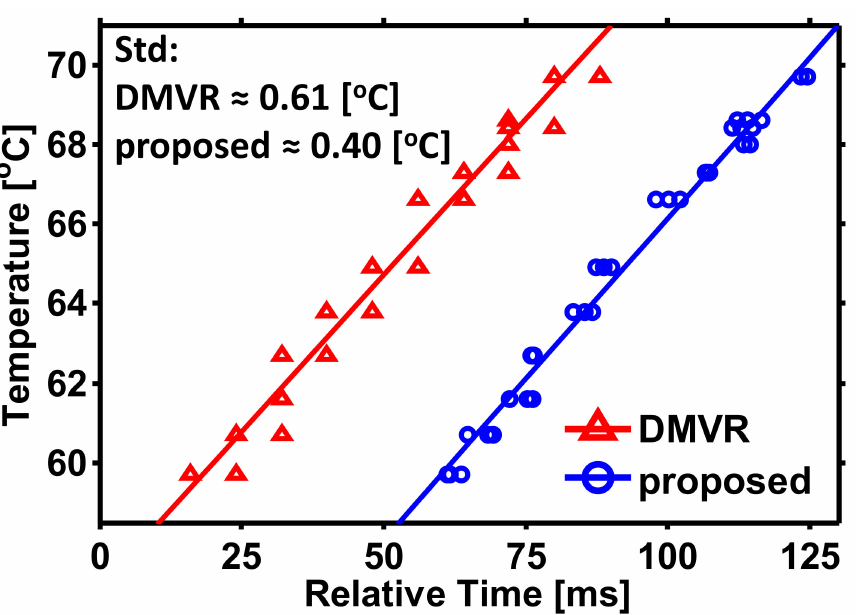
Figure 10. Relation between the temperatures and the relative time shifts. Temperature range: 59.7~69.7 ◦